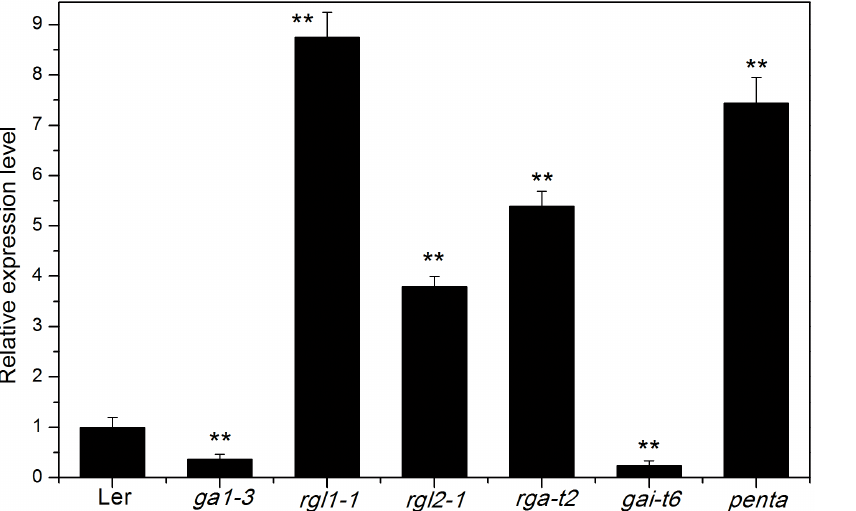
Figure 7. Effects of DELLA on AtEXP2 expression during seed germination. Expression level of AtEXP2 was measured in 24 h imbibed seeds of wild type, ga1-3 , and various DELLA mutants. penta indicates the ga1-3 gai-t6 rga-t2 rgl1-1 rgl2-1 mutant. Error bars represent SD. A Student’s t-test was calculated at the probability of 1% (**P , 0.01).